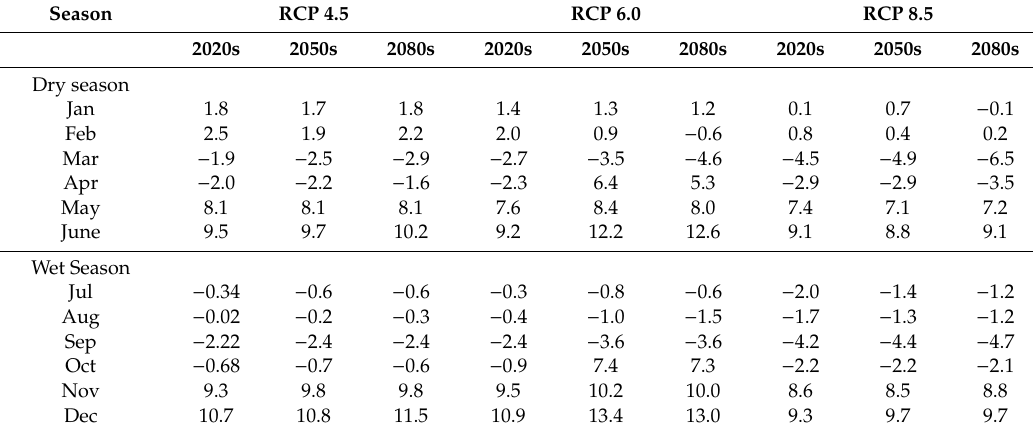
Table 3. Projected excess / shortage water supply under RCP scenarios 4.5, 6.0, and 8.5 for the periods